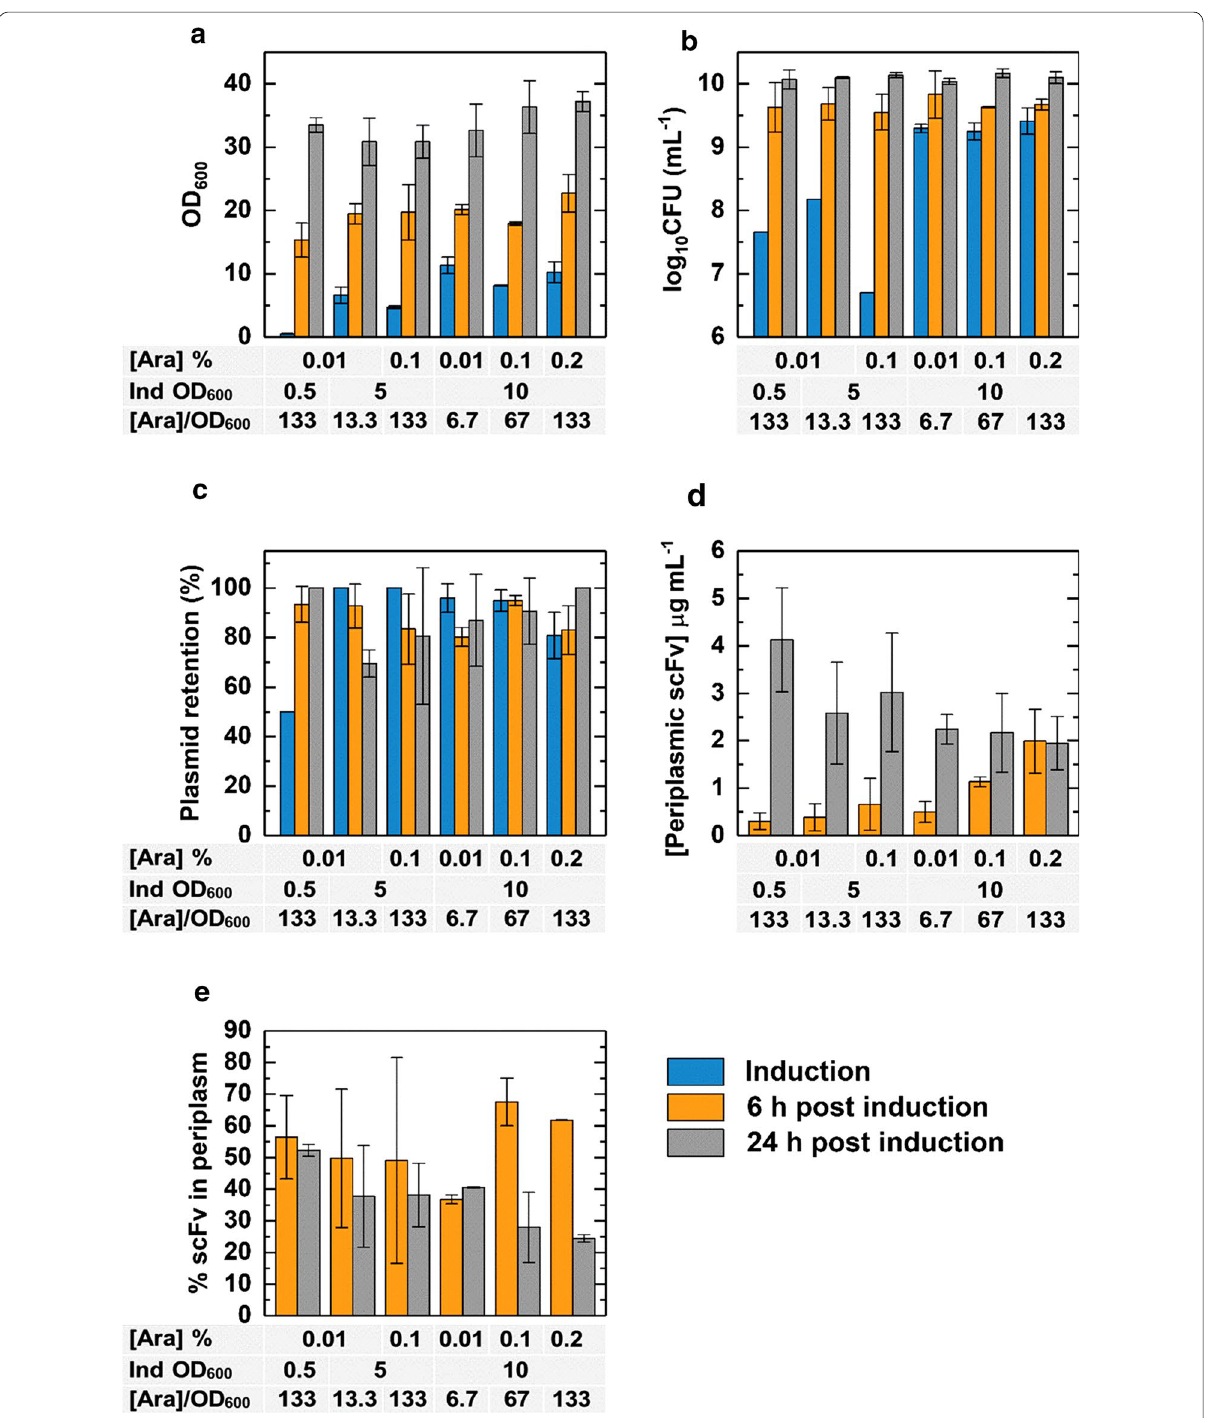
Fig. 6 Baffled shake flask experiments to determine the effect of different induction points and inducer concentrations. Cultures were grown in 100 mL of terrific broth in 500 mL baffled shake flasks and samples were taken at induction and at 6 h and 24 h after induction. Samples were analysed for OD 600 ( a ), CFU mL − 1 ( b ), percentage plasmid retention ( c ), periplasmic scFv concentration ( d ) and percentage of scFv in the periplasm ( e